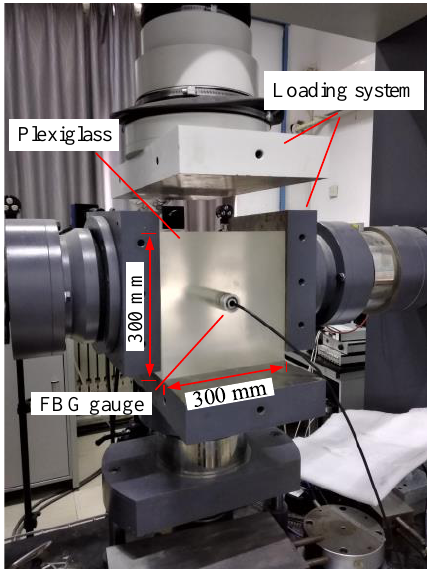
Figure 9. Experiment setup and plexiglass block containing a FBG sensor.